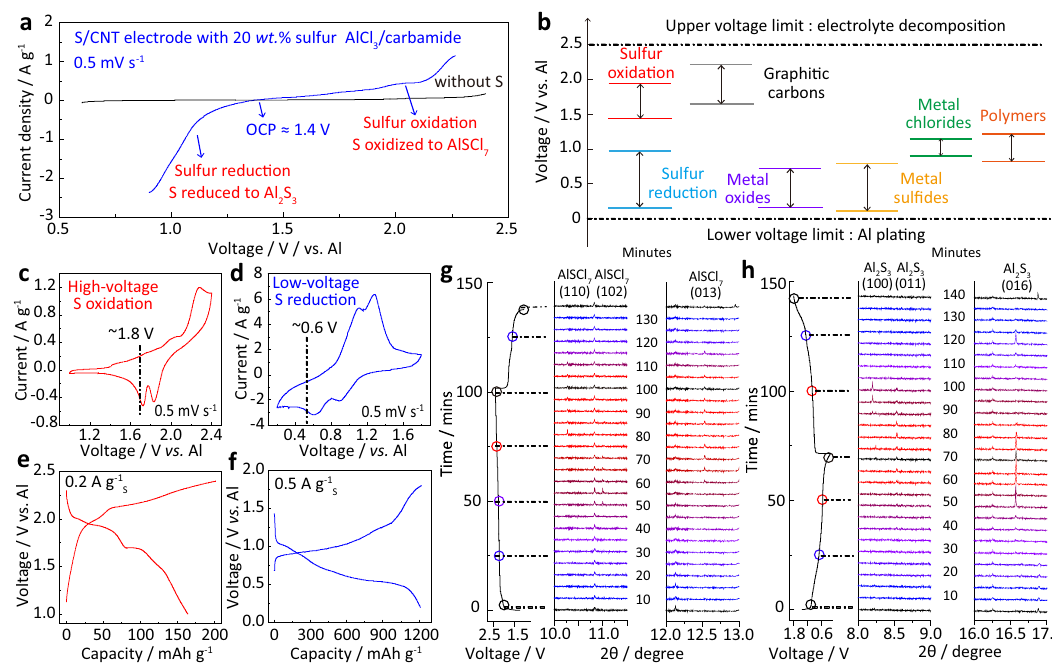
Fig. 1 The electrochemical oxidation and reduction of sulfur in ionic liquid. a LSV curves of S/CNT composite cathode in AlCl 3 /carbamide ionic liquid at 0.5 mV s − 1 with Al referenced electrode; the sulfur content in S/CNT is 20 wt.%; b the voltage comparison of sulfur oxidation and sulfur reduction with previously reported materials; CV curves of c sulfur oxidation and d sulfur reduction at 0.5 mV s − 1 ; galvanostatic charge – discharge curves of the S/CNT cathode based on e sulfur oxidation at 0.2 A g − 1 and f sulfur reduction at 0.5 A g − 1 ; the time-dependent in situ synchrotron-based XRD patterns for g sulfur oxidation and h sulfur reduction processes and the corresponding charge – discharge curves. The current densities for sulfur oxidation and sulfur reduction are 0.2 and 0.5 A g − 1 , respectively.